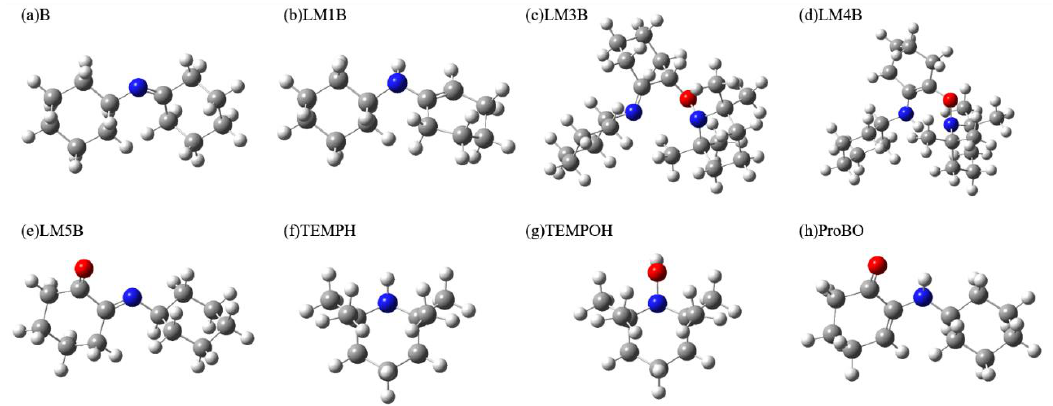
Figure 6. Calculated geometries of ( a ) reactant imine molecule B, ( b ) enamine tautomer intermediate LM1B, ( c ) α -aminoxylated species intermediate LM3B, ( d ) α -aminoxylated enamine intermediate LM4B, ( e ) intermediate LM5B, ( f ) TEMPH, ( g ) TEMPOH and ( h ) α -amino-enones product ProBO.